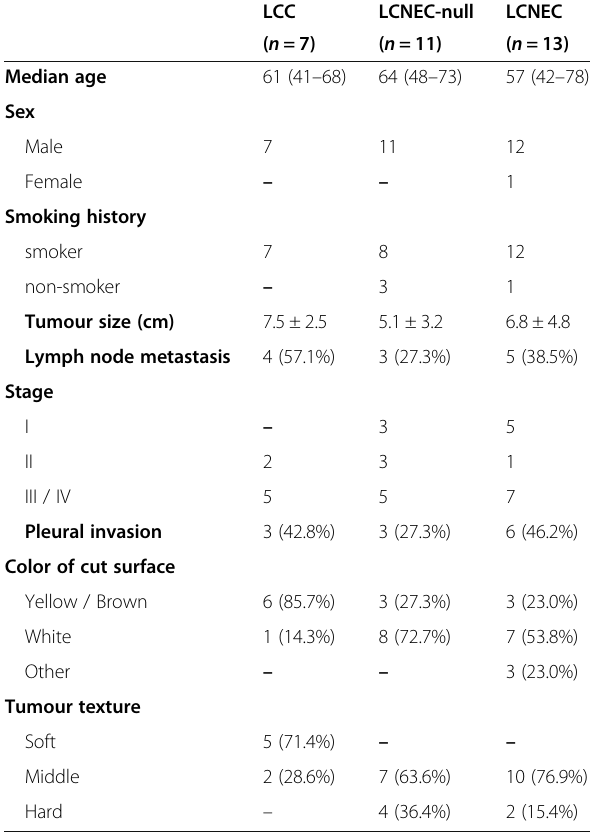
Table 1 Contrast of the clinicopathology of LCC, LCNEC-null and